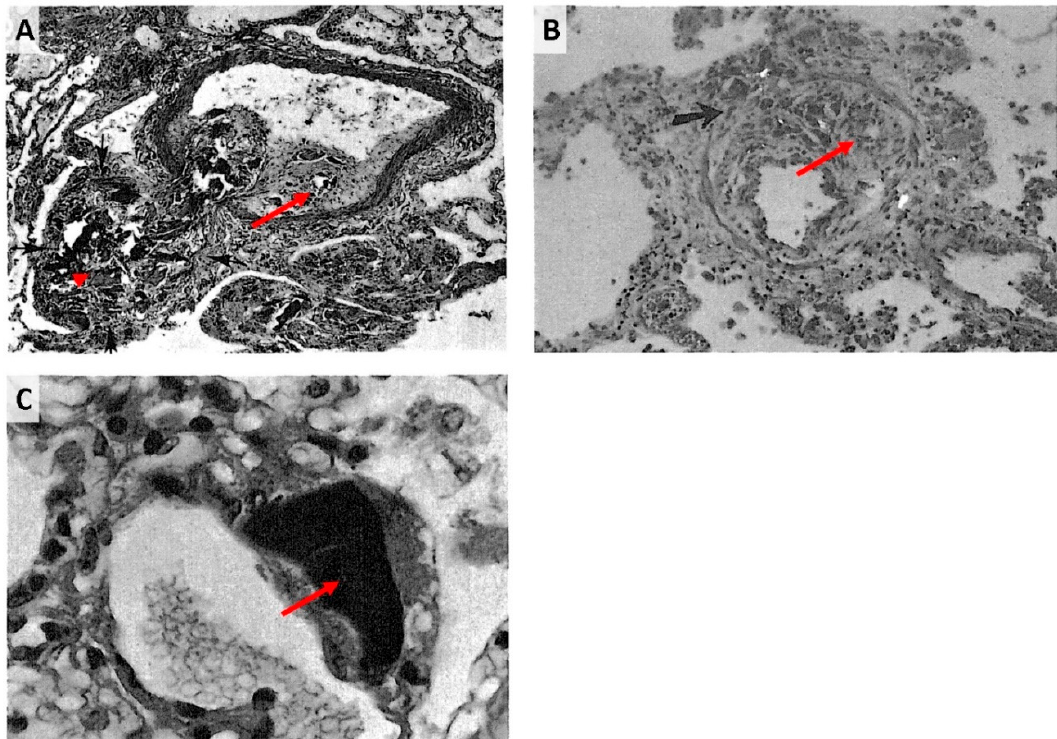
Figure 12. The pulmonary vascular lesions with intravenous drug abuse analyzed through the prism of angiophagy. ( A ) Stage I (red arrow) and III (red arrowhead) angiophagy in a branch of a muscular pulmonary artery occluded by cellulose emboli (darkly stained spicules) and a thrombus (outlined by black arrows). The tail of the thrombus protrudes into the parent artery, which also shows eccentric intimal fibrosis. Perivascular cellulose granulomas are present in the lower portion of the field. (Periodic acid-Schiff stain; × 80.) ( B ) Stage II (red arrow) angiophagy in a small muscular artery with a recanalized lumen, eccentric fibrosis and granulomatosis following organization of a thrombus induced by talc emboli. Spicules of optically active material are consistent with talc. Transmural extension of a foreign body granuloma is indicated by the black arrow. (Hematoxylin and eosin stain; × 150; partially polarized light.) ( C ) Stage III angiophagy (red arrow) with an unidentified homogeneous, amorphous, brown material adjacent to a pulmonary arteriole. (Hematoxylin and eosin stain; × G50.) Reprinted from The pulmonary vascular lesions of intravenous drug abuse, J F Tomashefski Jr, C S Hirsc, h Hum Pathol. 1980 Mar;11(2):133-45, Copyright (1980), with permission from